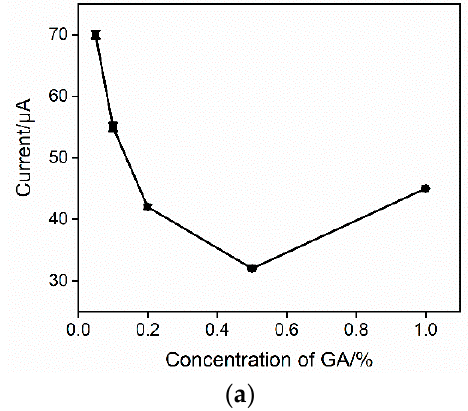
Figure 5. DPV peak current for the PSA-bound immunosensor prepared using different concentra- tions of GA ( a ) or different reaction times for the immobilization of the antibody ( b ). The electrolyte is Fe(CN) 63 − /4 − (2.5 mM) containing 0.1 M KCl. The concentration of PSA was 1 ng mL − 1 . Error bars represent the standard deviation of three measurements.